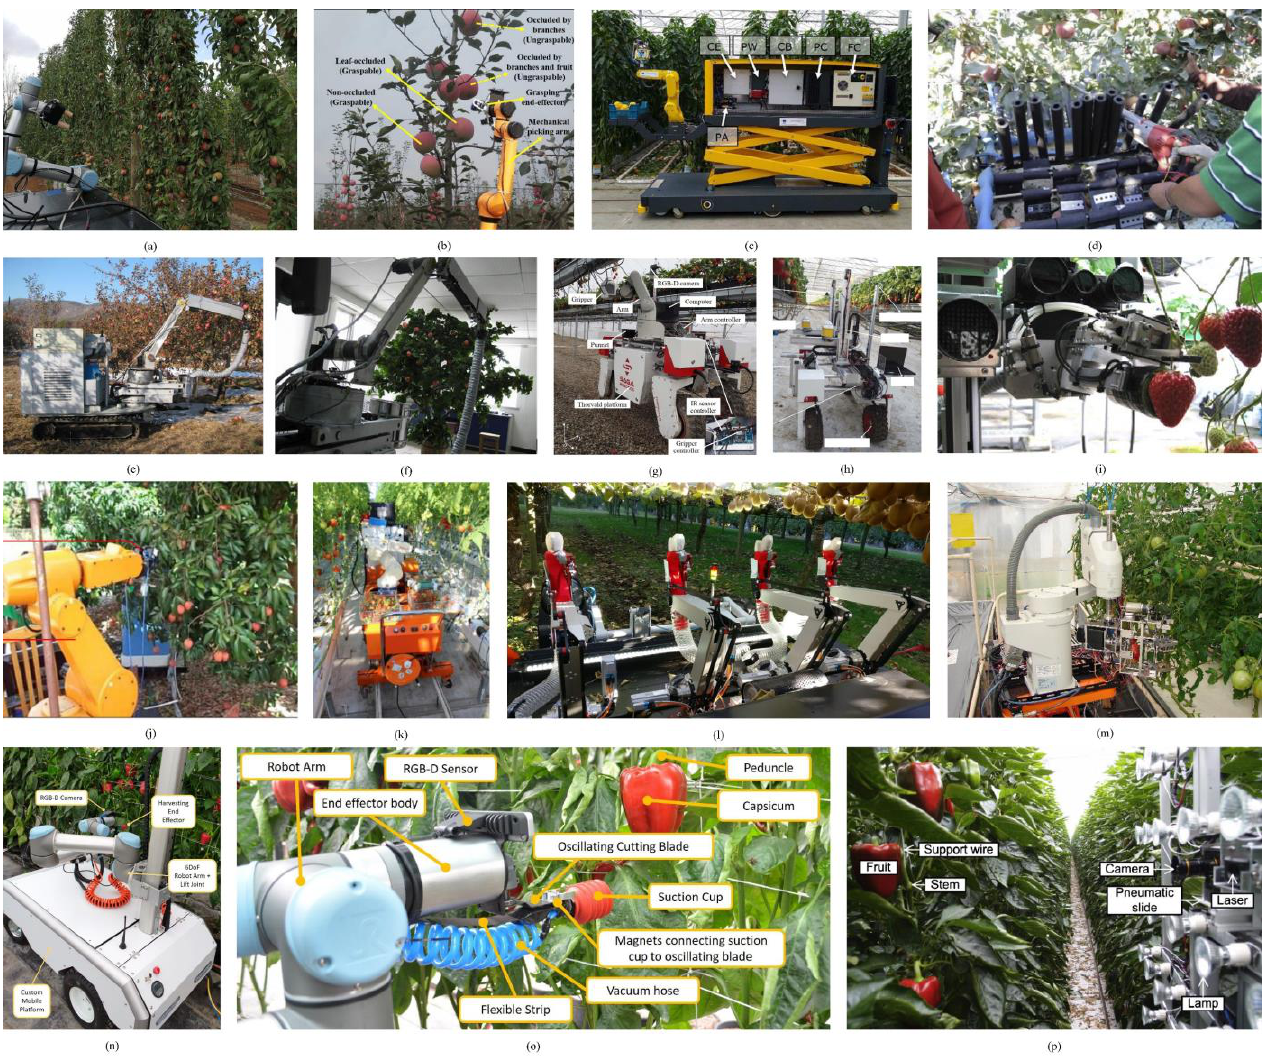
Figure 2. Typical harvesting robots: ( a ) a plum harvesting robot (Photo: Reprinted with permission from Ref. [12]. 2021, Brown, J.); ( b , d – f ) apple harvesting robots (Photo: Reprinted with permission from Ref. [13]. 2021, Yan, B.; Ref. [14]. 2017, He, L.; Ref. [15]. 2012, Ji, W.; Ref. [16]. 2011, Zhao, D.); ( c , n – p ) sweet pepper harvesting robots (Photo: Reprinted with permission from Ref. [17]. 2020, Arad, B.; Ref. [18]. 2017, Lehnert, C.; Ref. [19]. 2014, Bac, C.W.); ( g – i ) strawberry harvesting robots (Photo: Reprinted with permission from Ref. [6]. 2020, Xiong, Y.; Ref. [7]. 2019, Xiong, Y.; Ref. [20]. 2010, Hayashi, S.); ( j ) a litchi harvesting robot (Photo: Reprinted with permission from Ref. [21]. 2018, Xiong, J.); ( k , m ) tomato harvesting robots (Photo: Reprinted with permission from Ref. [22]. 2018, Feng, Q.; Ref. [23]. 2010, Kondo, N.); ( l ) a kiwifruit harvesting robot (Photo: Reprinted with permission from Ref. [24]. 2019, Williams, H.A.M.).